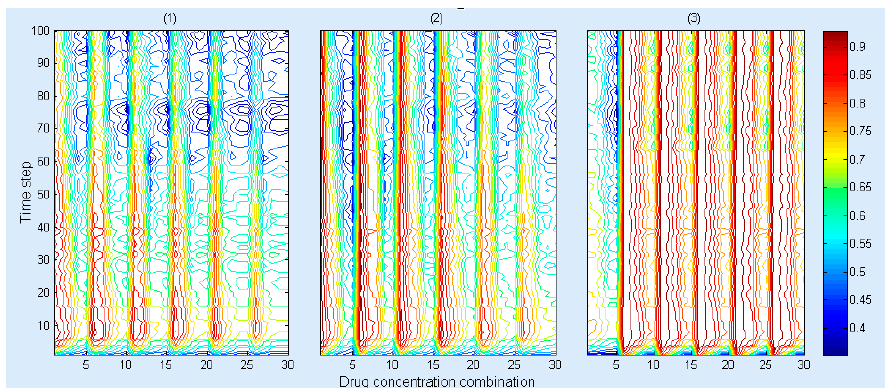
Figure 4. The cell’s mortality rate ( Msrate ) under the different drug concentration combinations for ( 1 ) gefitinib and rosiglitazone; ( 2 ) erlotinib and imatinib and ( 3 ) gefitinib and quinacrine. The x, y axes represent drug concentration combination and time step, respectively, wherein, 10, 20 and 30 on the x axis represent a drug concentration combination detailed in Supplementary Table 1, Supplementary Table 2 or Supplementary Table 3, respectively. The legend represents the value of the Msrate .